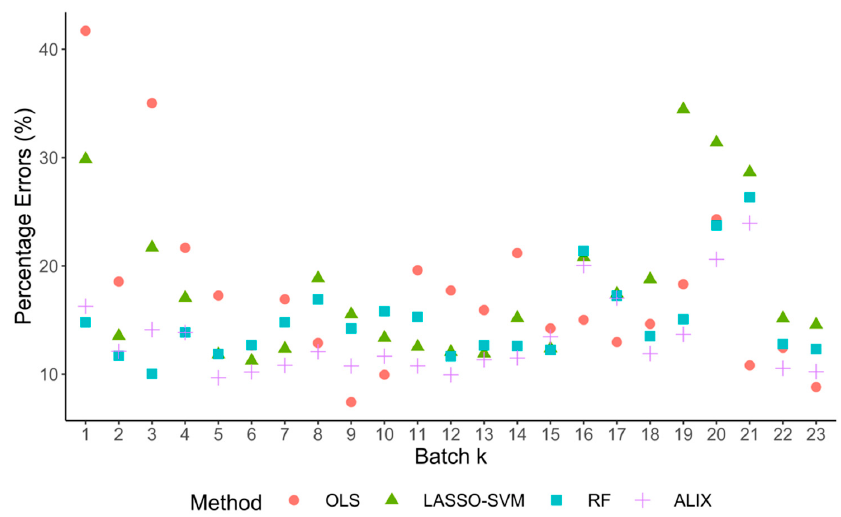
ALIX method has better performance than other methods in general.